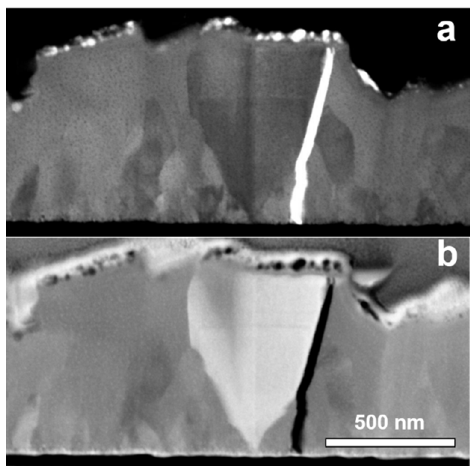
Figure 2. Scanning transmission electron microscopy images taken from the focus ion beam (FIB) lamella of the PB films: ( a ) bright-field image, ( b ) dark-field image.